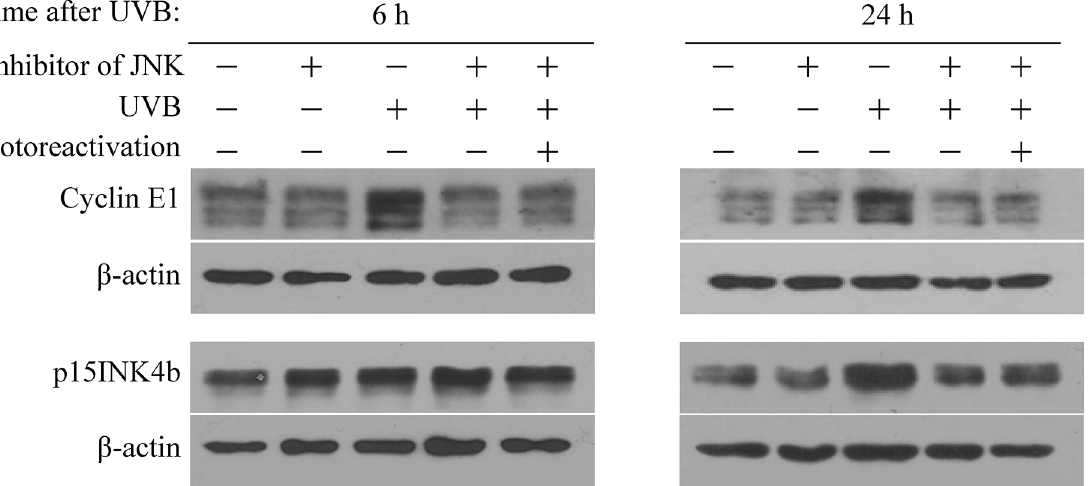
Fig 4. Induction of cyclin E1 and p15INK4b protein expression upon UVB exposure is regulated through the JNK signalling pathway in HaCaT cells. Keratinocytes transfected with CPD-PL Ψ -mRNA were incubated in serum-free medium supplemented with JNK inhibitor (SP600125) for 1 h. Immediately thereafter, cells were irradiated with a physiological dose of UVB or left untreated followed by exposure to photoreactivating light (or not) for 1 h. The cells were cultured further in serum-free medium supplemented with the inhibitor. Cells were harvested for western blot assay at the indicated time. Protein levels of cyclin E1, p15INK4b, and β -actin are noted. The figure shows representative results from three independent